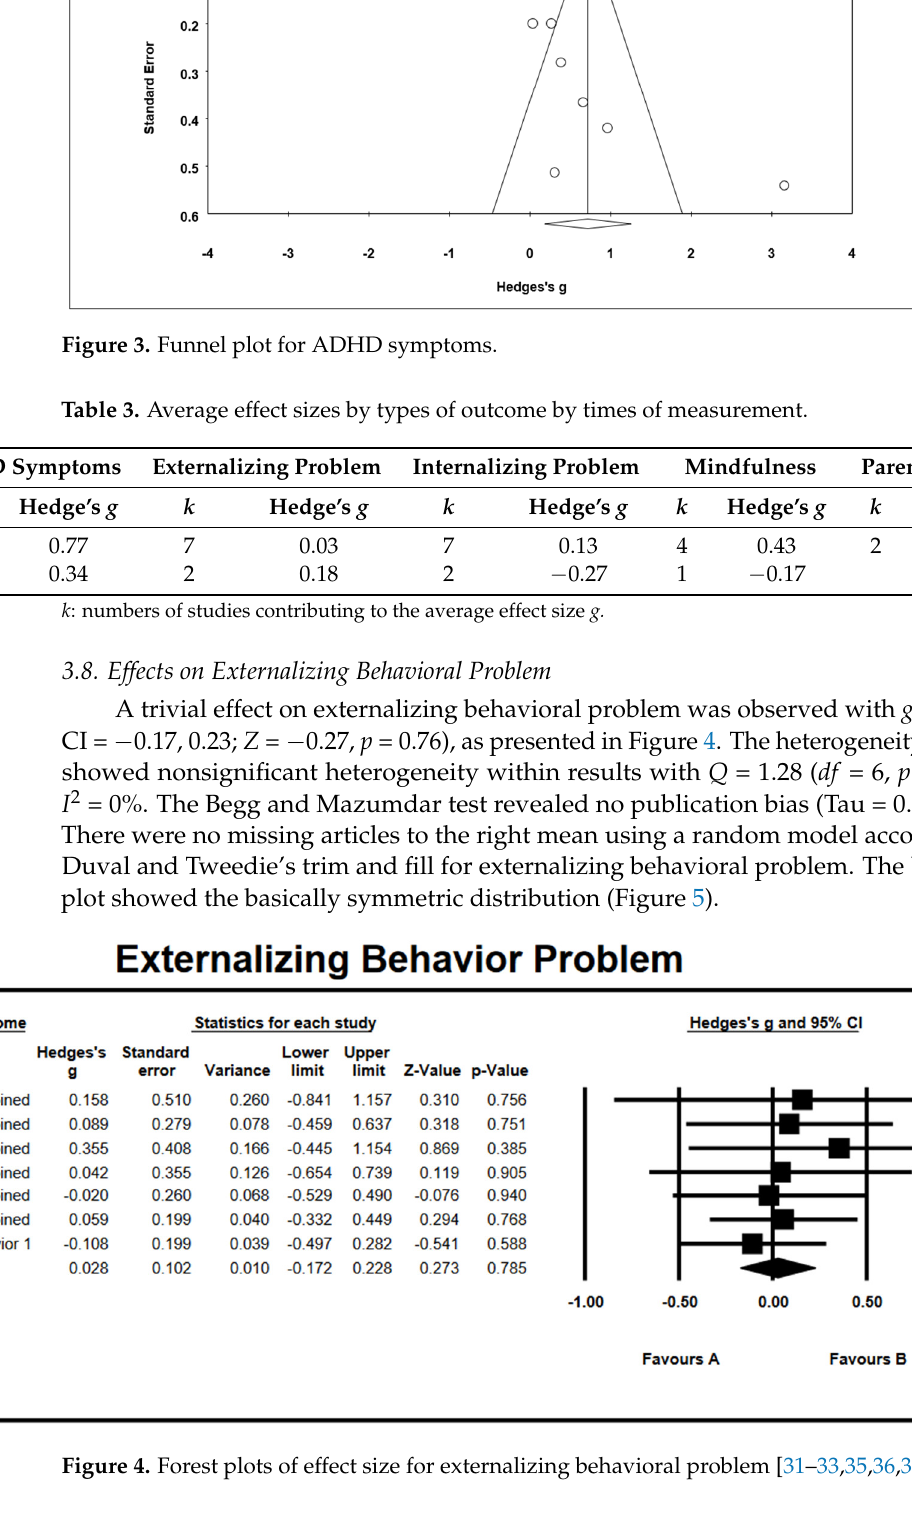
Figure 4. Forest plots of effect size for externalizing behavioral problem [31–33,35,36,38,39].